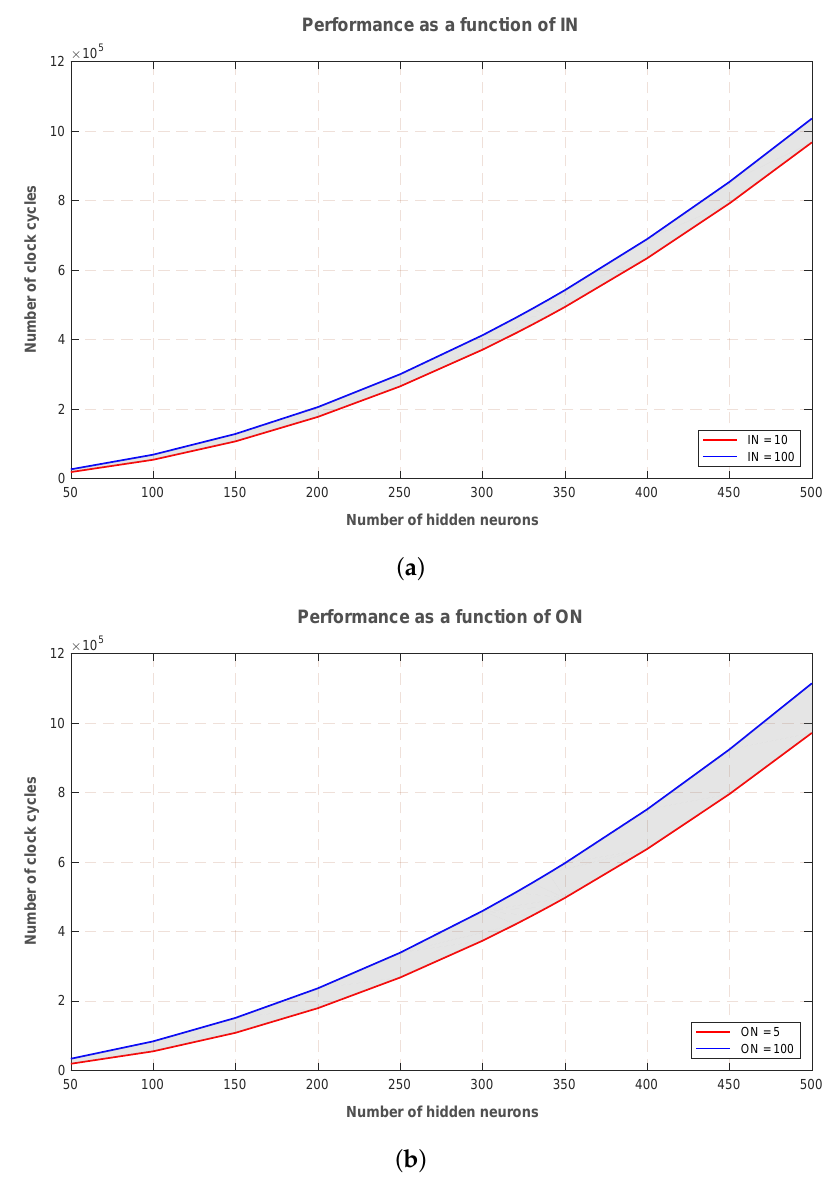
Figure 3. Performance of the OS-ELM FPGA core. ( a ) shows the number of cycles needed to execute a sequential training iteration as a function of the number of hidden neurons, ˜ N , and varying the number of inputs, IN, of the SLFN between ten and 100 (using ON = 7), and ( b ) represents the required number of cycles as a function of the number of hidden neurons, ˜ N , varying the number of outputs of the SLFN between five and 100 (using IN =